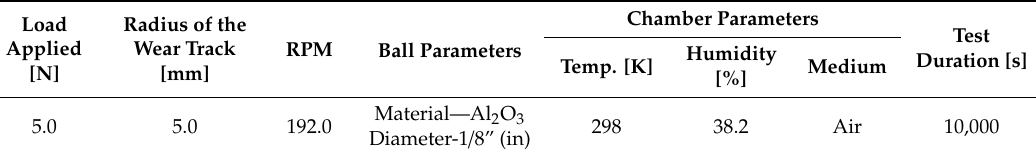
Table 1. The ball-on-disc test